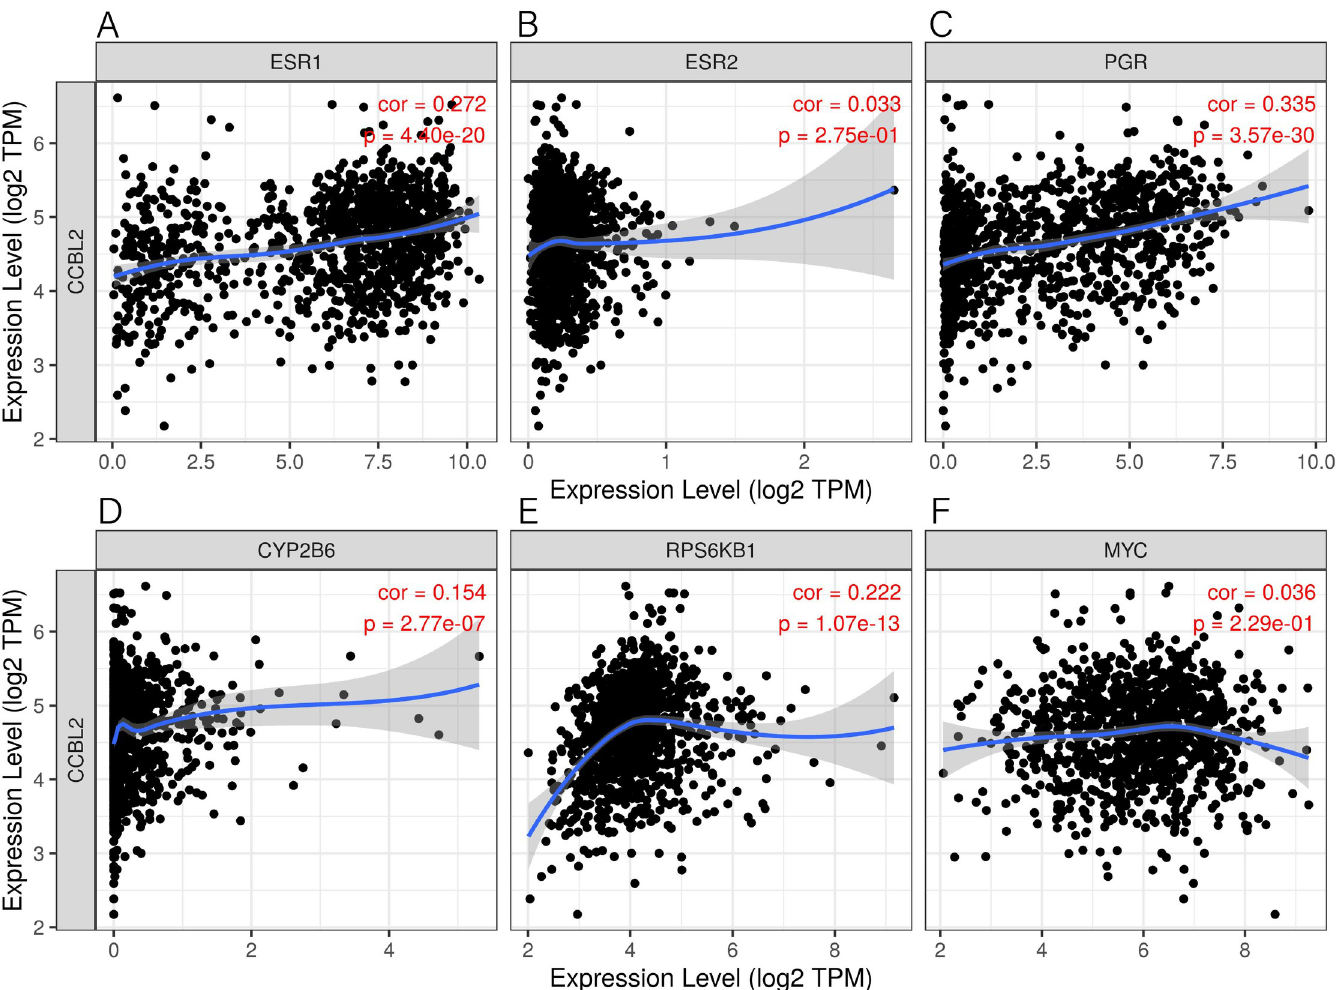
Fig 10. Correlation analysis between CCBL2 and relevant genes. Results included ESR1 (A), ESR2 (B), PGR (C), CYP2B6 (D), RPS6KB1 (E), and MYC (F) through TIMER databases. Abbreviation: TIMER, Tumor Immunoassay